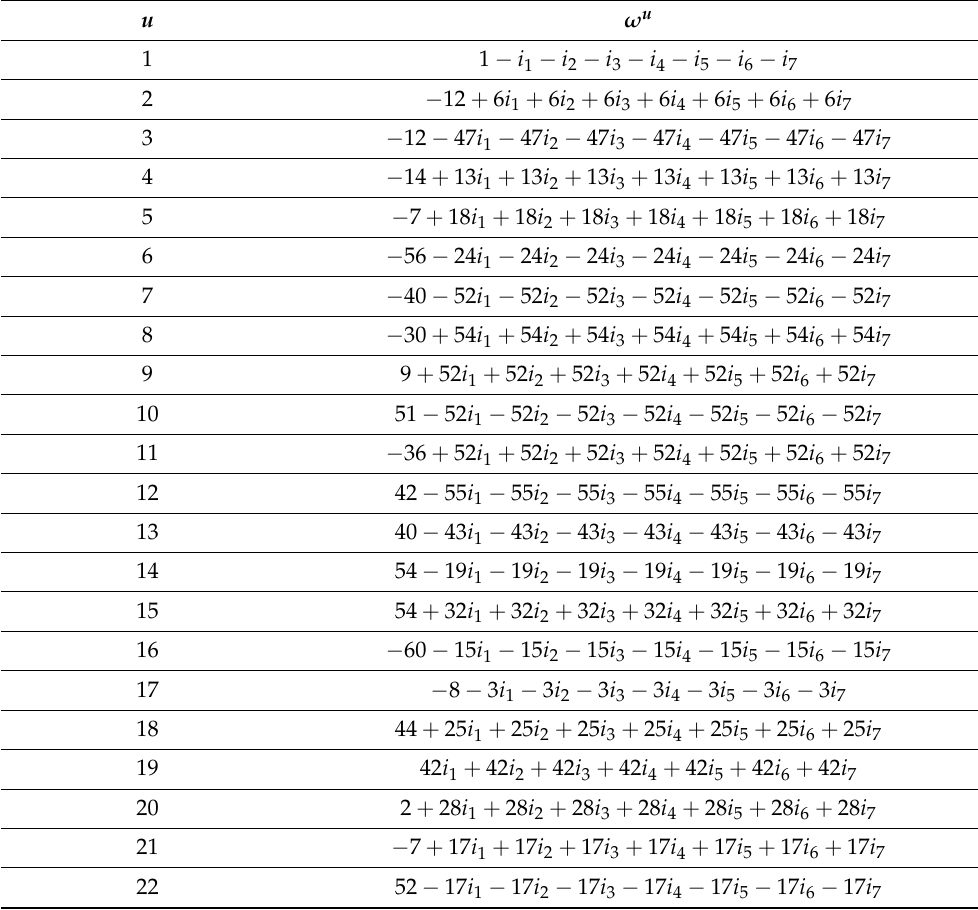
Table 1. Cyclic group over the residue class of octonion integers generated by ω